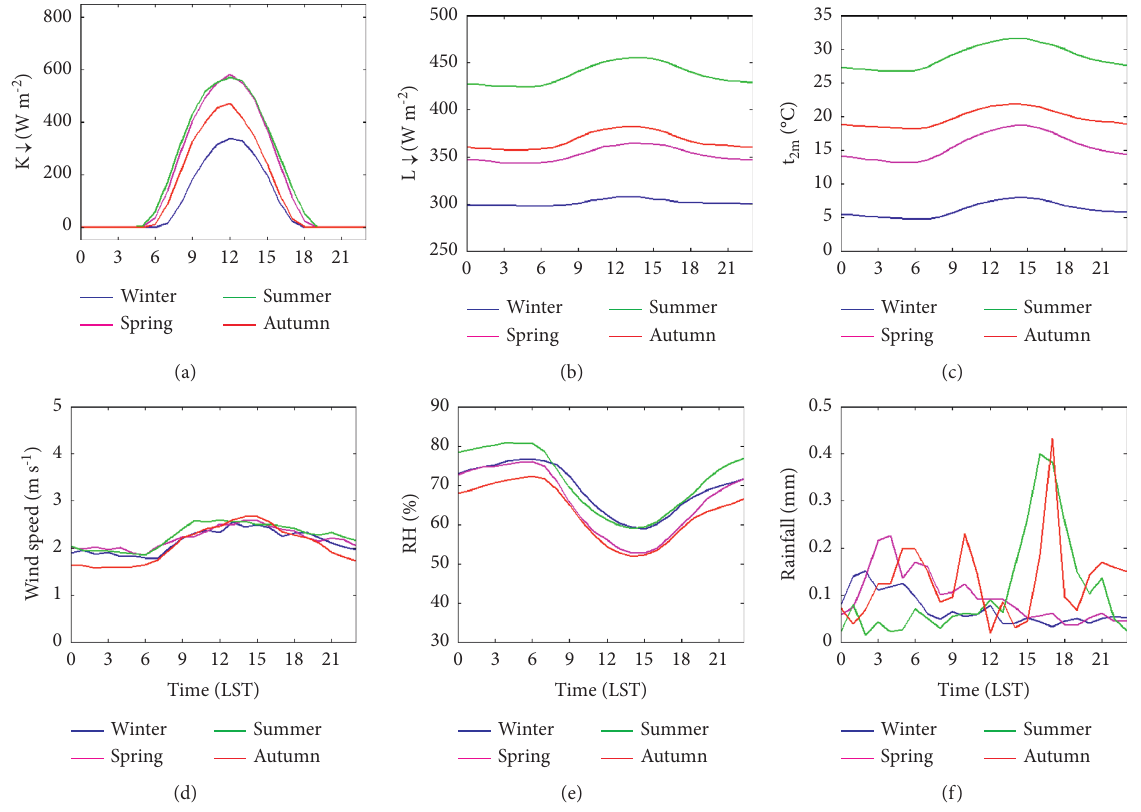
Figure 1: Seasonal mean diurnal variations of surface meteorological input variables used in the SLUCM: (a) downward shortwave radiation (K ↓ ), (b) downward longwave radiation (L ↓ ), (c) 2-meter air temperature (t 2m ), (d) 10-meter wind speed, (e) 2-meter relative humidity (RH), and (f)